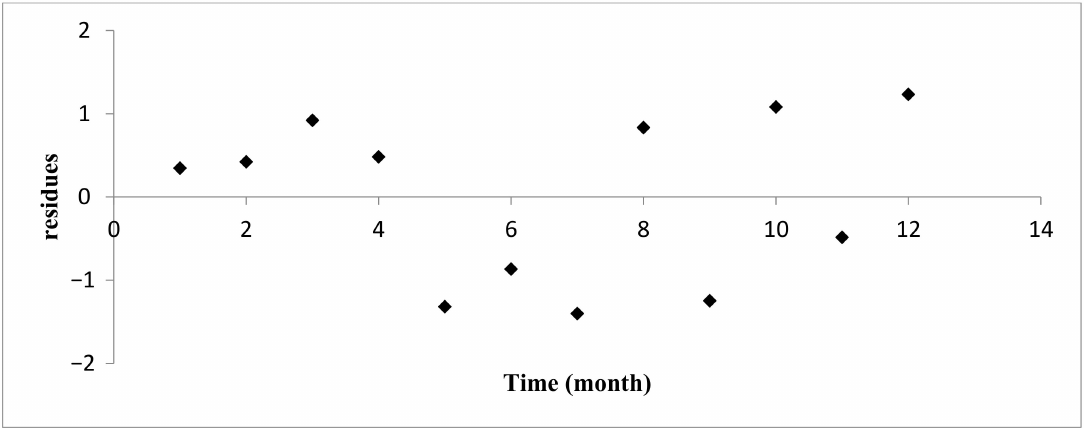
Figure 4. Residual regression line distribution of long-stability study